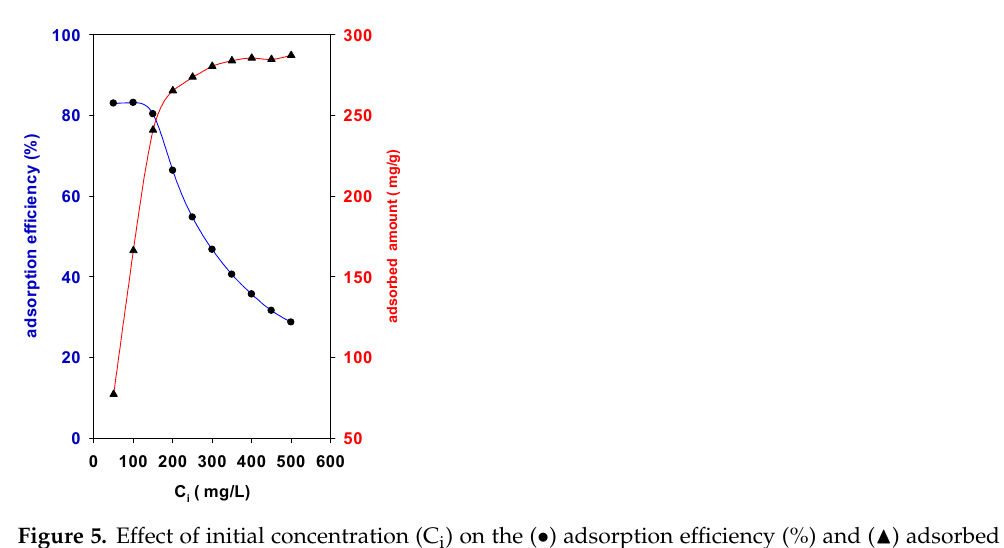
Figure 5. Effect of initial concentration (C i ) on the ( ● ) adsorption efficiency (%) and ( ▲ ) adsorbed amount of BB ‐ 41 (mg/g) using Zr(12) ‐ PCH material.